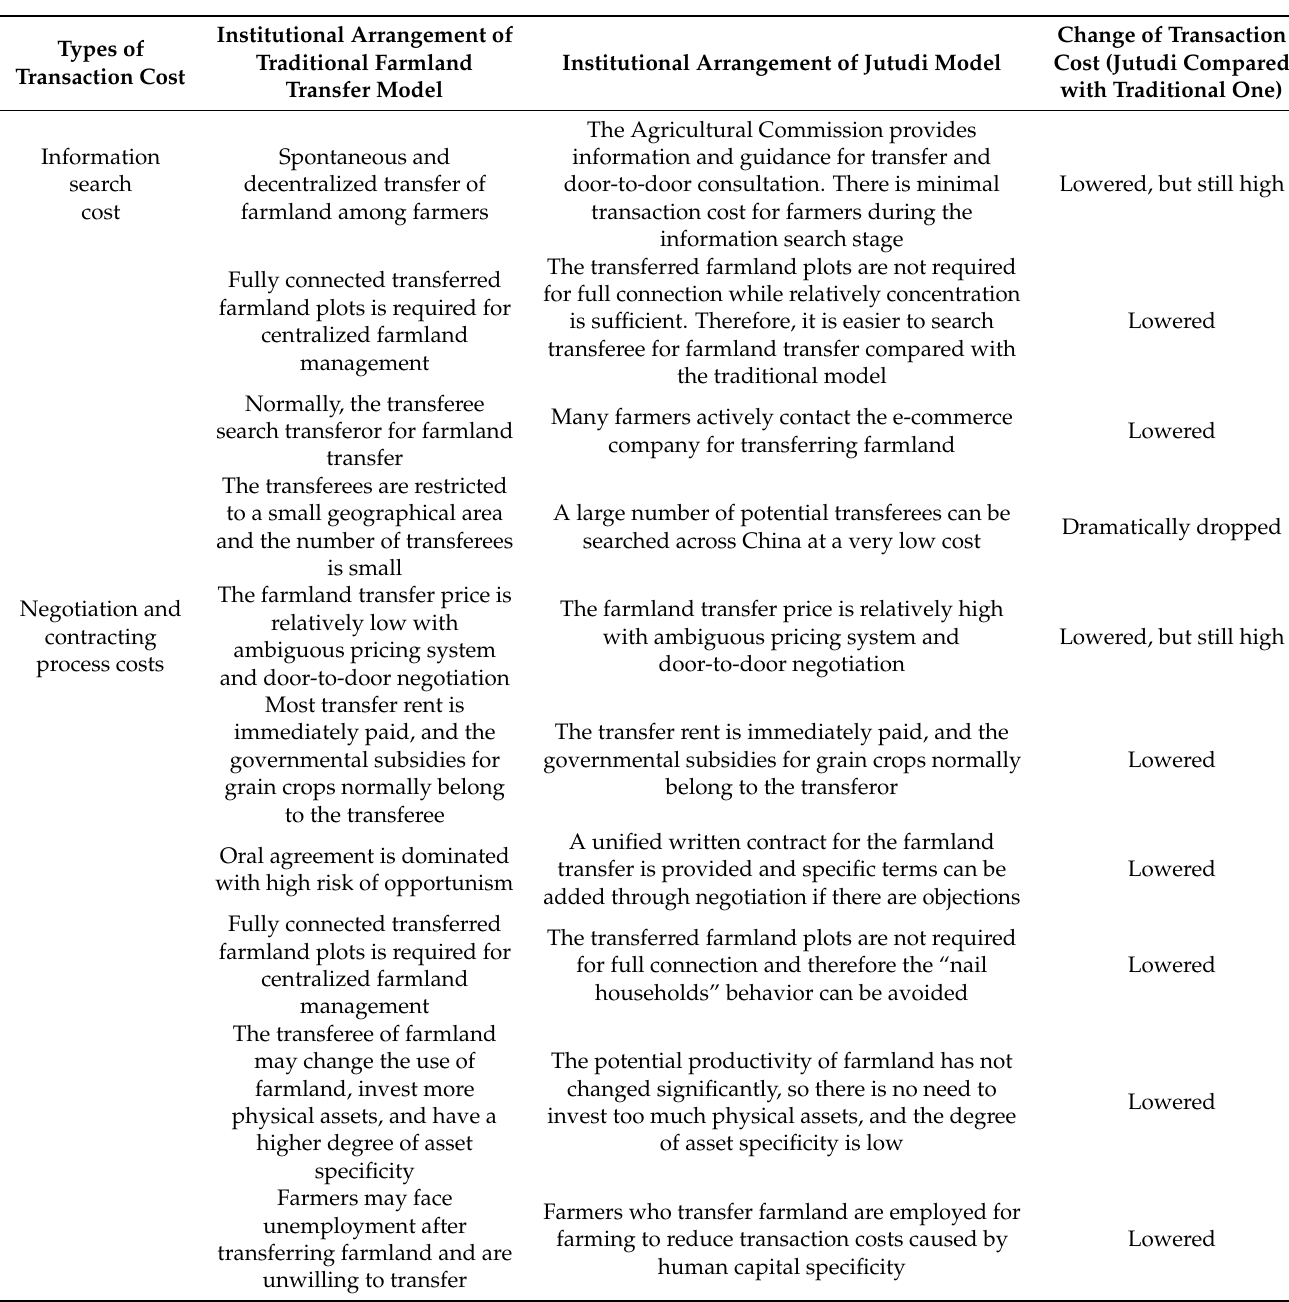
Table 1. Change in transaction cost of farmland transfer in the Jutudi